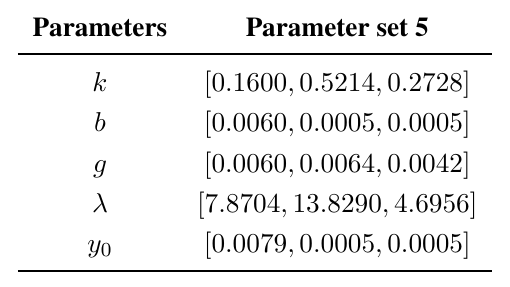
Table 5. Parameter set used for Example 3 for N = 3.